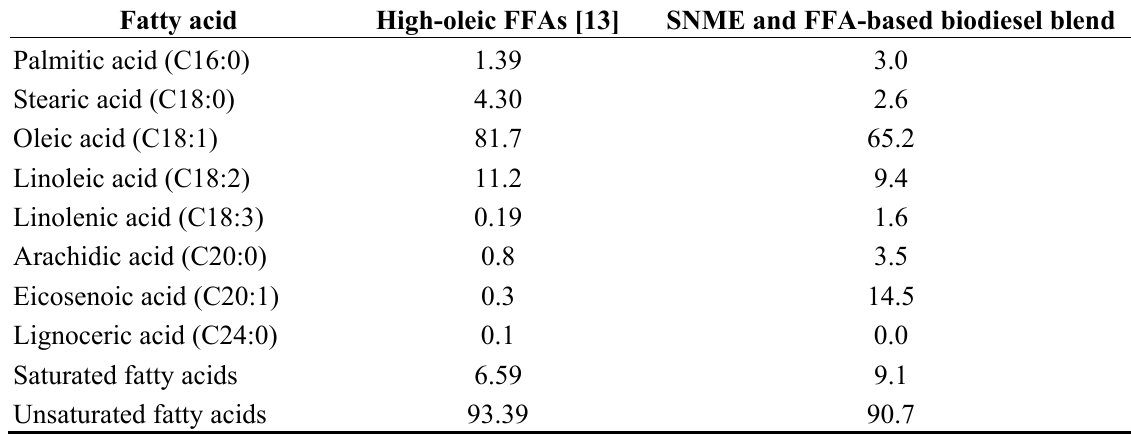
Table 1. Fatty acid composition of high-oleic FFAs as well as SNME and FFA-based biodiesel blend a